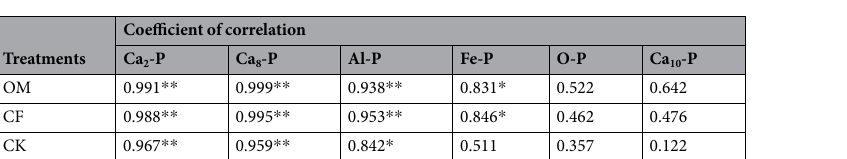
Table 5. The correlation coefficient ( r ) between different phosphorus fractions and Olsen-P under different treatments. * P ≤ 0.05 and ** P ≤